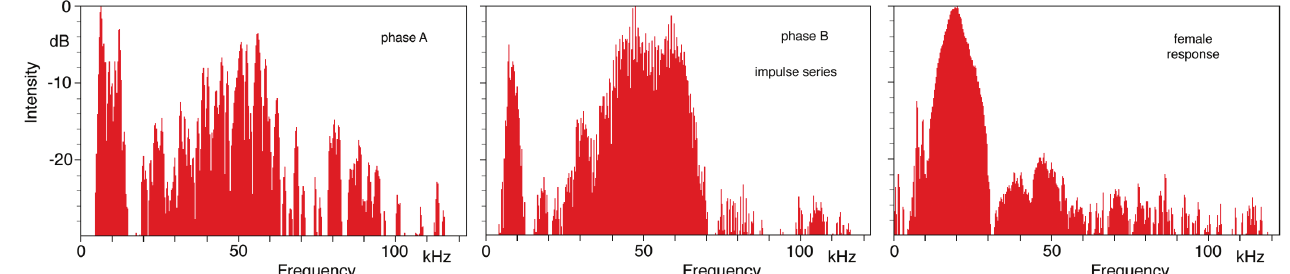
Figure 17. Power spectra of different parts of the male calling song and of the female response of E. fulva .